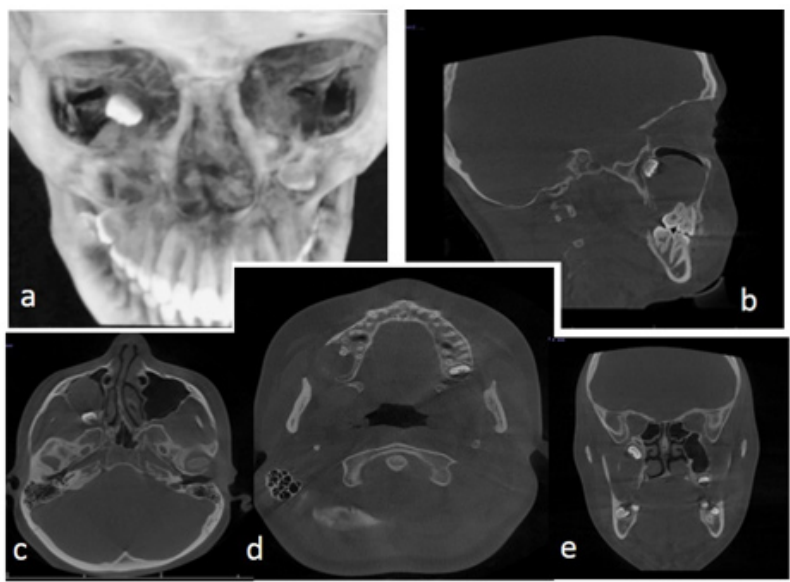
Figure 2. Multiplanar cone beam computed tomography (CBCT) sections: ( a ) three-dimensional; ( b ) sagittal; ( c , d ) axial; ( e ) coronal slices showing the posterosuperior position of the ectopic right third maxillary molar inside the maxillary sinus with associated pericoronal hyperdense lesion and radiographic evidence of oroantral communication due to its destructive effect on the maxillary sinus floor and the alveolar